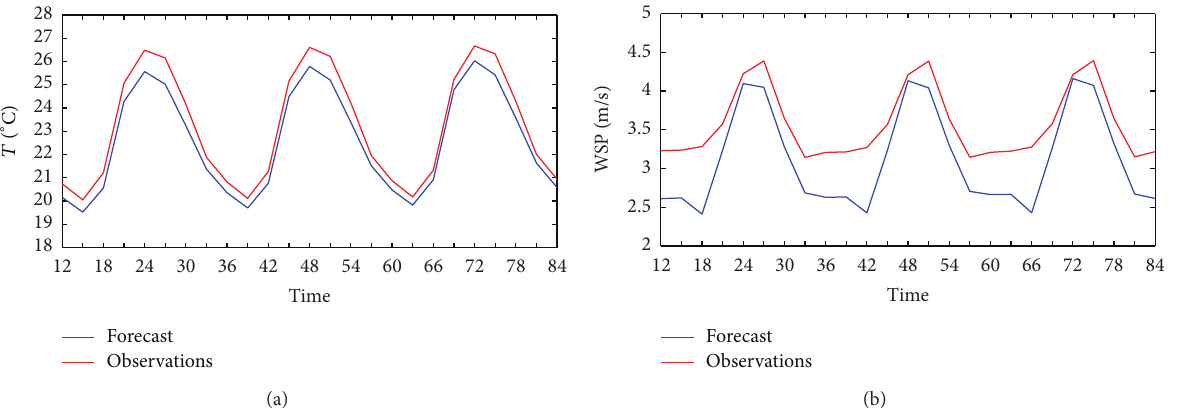
Figure 8: Time series of the forecast and observations for temperature (a) and wind speed (b) in summer.